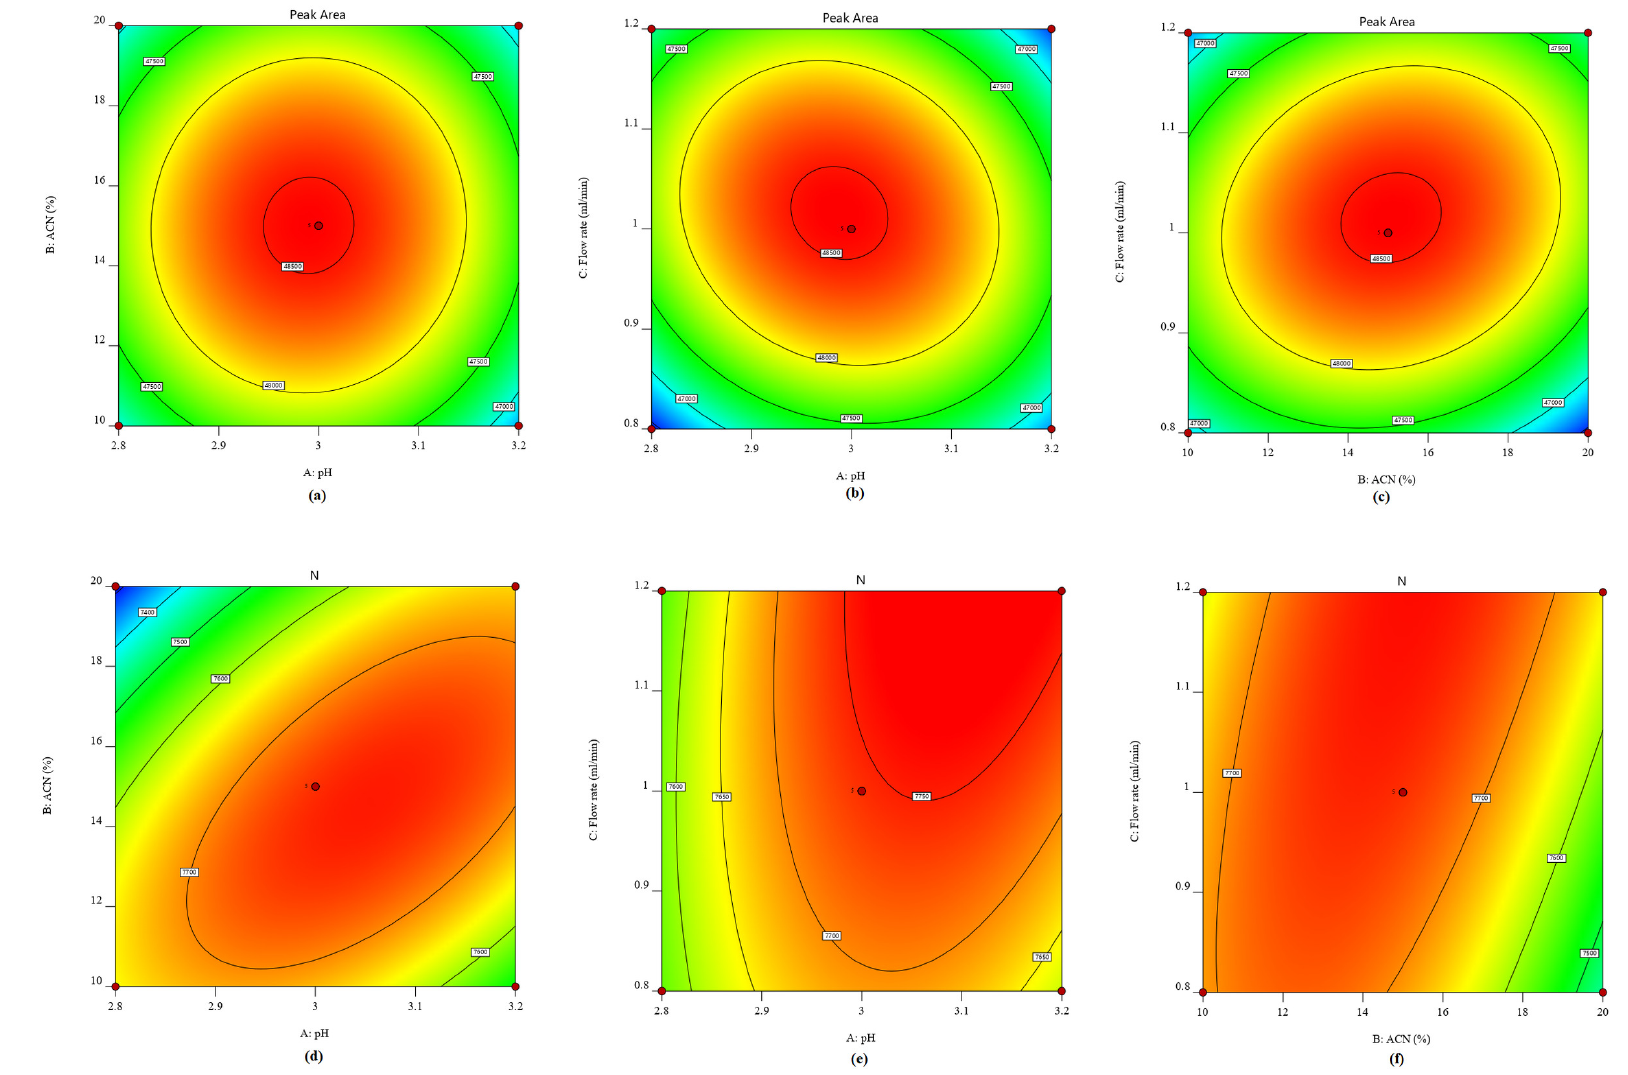
Figure 2. 2D contour plot with peak area signifying the relations between (a) pH and ACN (b) pH and flow rate (c) ACN and flow rate; with theoretical plate (d) pH and ACN (e) pH and flow rate (f) ACN and flow rate to quantify acetic acid content in pharmaceutical